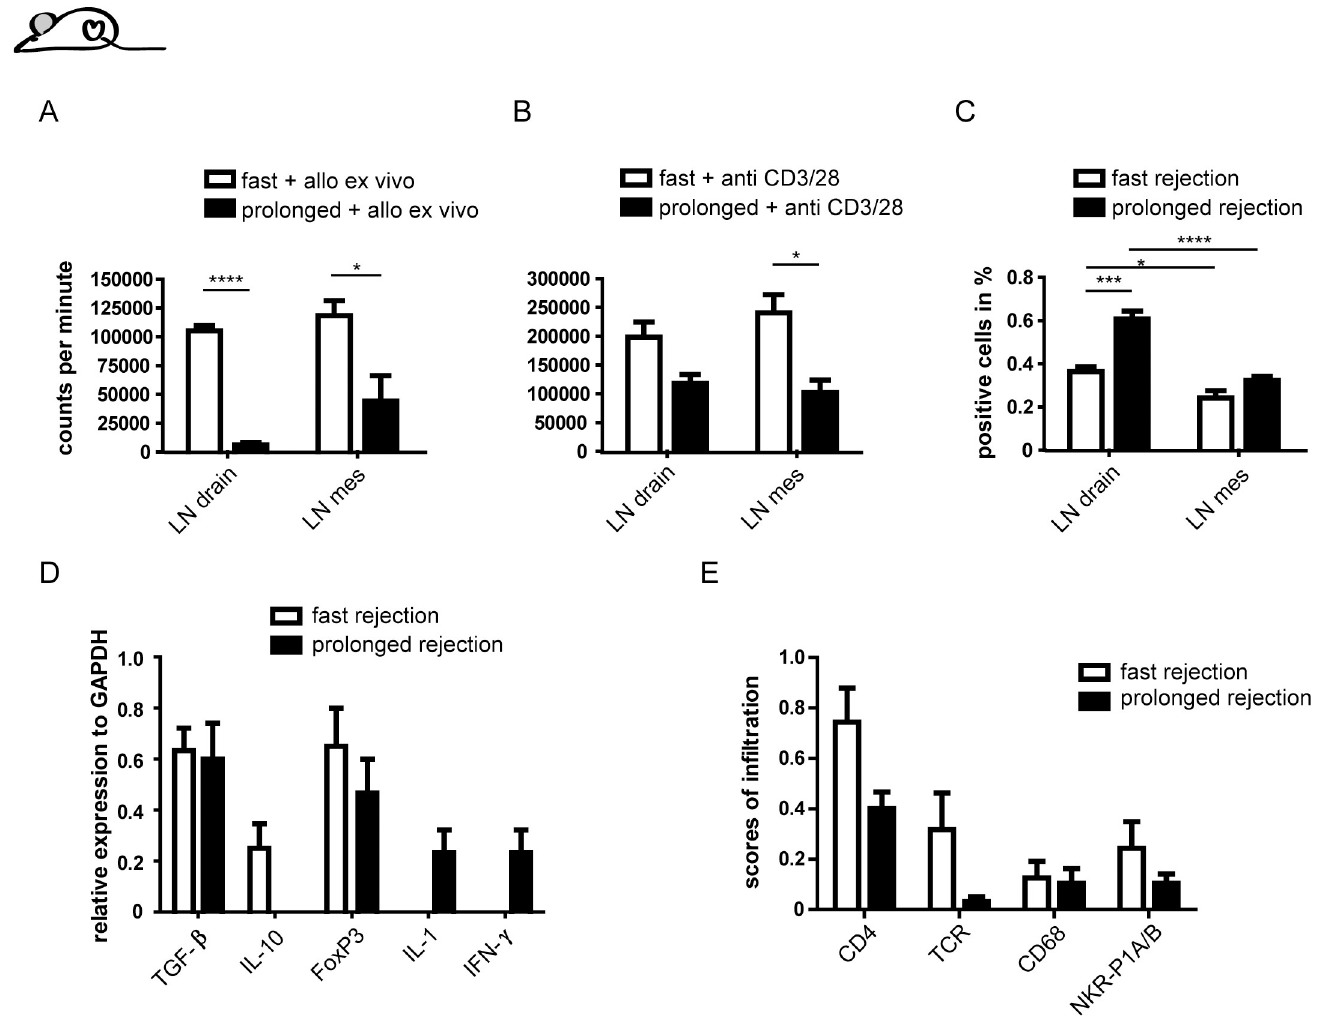
Fig 3. Lew.1a draining LN cells reveal increased NK cell ratios and suppressed proliferation upon specific re-stimulation. Lew wt and Lew.1a rats received allogeneic cell transplantation of 1x10 4 small aggregates of muscle cells from collagenase digested heart tissue subcutaneously in the ear (Lew.1a heart cells ! Lew wt (fast); Lew.1u7B heart cells ! Lew.1a recipients (prolonged)). Eight days after Tx rats were sacrificed. Draining cervical LN and (as intrinsic control) mesenteric LN were prepared and tested in MLR for proliferative response and in flow cytometry for NK cell proportions, respectively. (A) Proliferation analyses of 2x10 5 lymphocytes derived from draining cervical and mesenteric LN of Lew wt and Lew.1a rats after specific re-stimulation with 2x10 5 irradiated splenocytes of the graft donor strain showed a significantly reduced proliferation of LN cells derived from Lew.1a rats when compared to Lew wt rats. (B) Unspecific stimulation of the lymphocytes with plate-bound mAb anti-CD3 and soluble anti-CD28 revealed general capacity of the lymphocytes to proliferate. (C) Percentages of NK cells in draining LN of Lew wt and Lew.1a recipients 8 days post placement of allogeneic heart cells in the ear. We observed a significant increase of NK cells in draining LN of Lew wt and significantly more pronounced in Lew.1a rats, when compared to mesenteric control LN. (D) mRNA expression in draining LN cells identical to the afore presented analyses in A-C. The cells were transferred into lysis buffer immediately after preparation and after mRNA purification subsequently transformed into cDNA. The outcome of a more suppressive cytokine-profile in Lew wt in comparison to a more inflammatory profile in Lew.1a recipients was surprising. (E) Scores of infiltrating CD4 + , TCR + , CD68 + and NKR-P1A/B + cells into ear tissue with regard to infiltration in syngeneic controls 8 days after Tx. The assessment revealed a clearly higher infiltration in Lew wt recipients in particular of T cells and monocytes. However, the infiltration of immune cells in general was very low. Results are presented as mean ± SEM of 4 individuals per group. Significance is indicated with � for p-values � 0.05, �� for p-values � 0.005, ��� for p- values � 0.0005 and ���� for p-values � 0.0001. If no asterisk is shown in the respective graph the results were not significantly